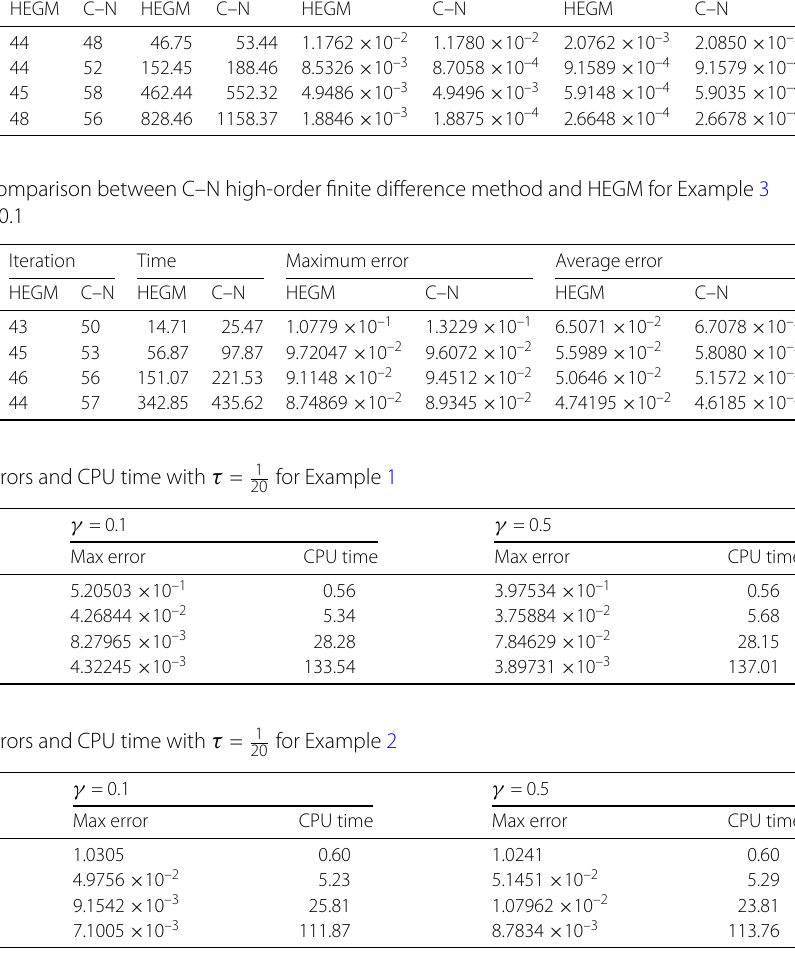
Table 5 Comparison between C–N high-order finite difference method and HEGM for Example 3 when γ = 0.75